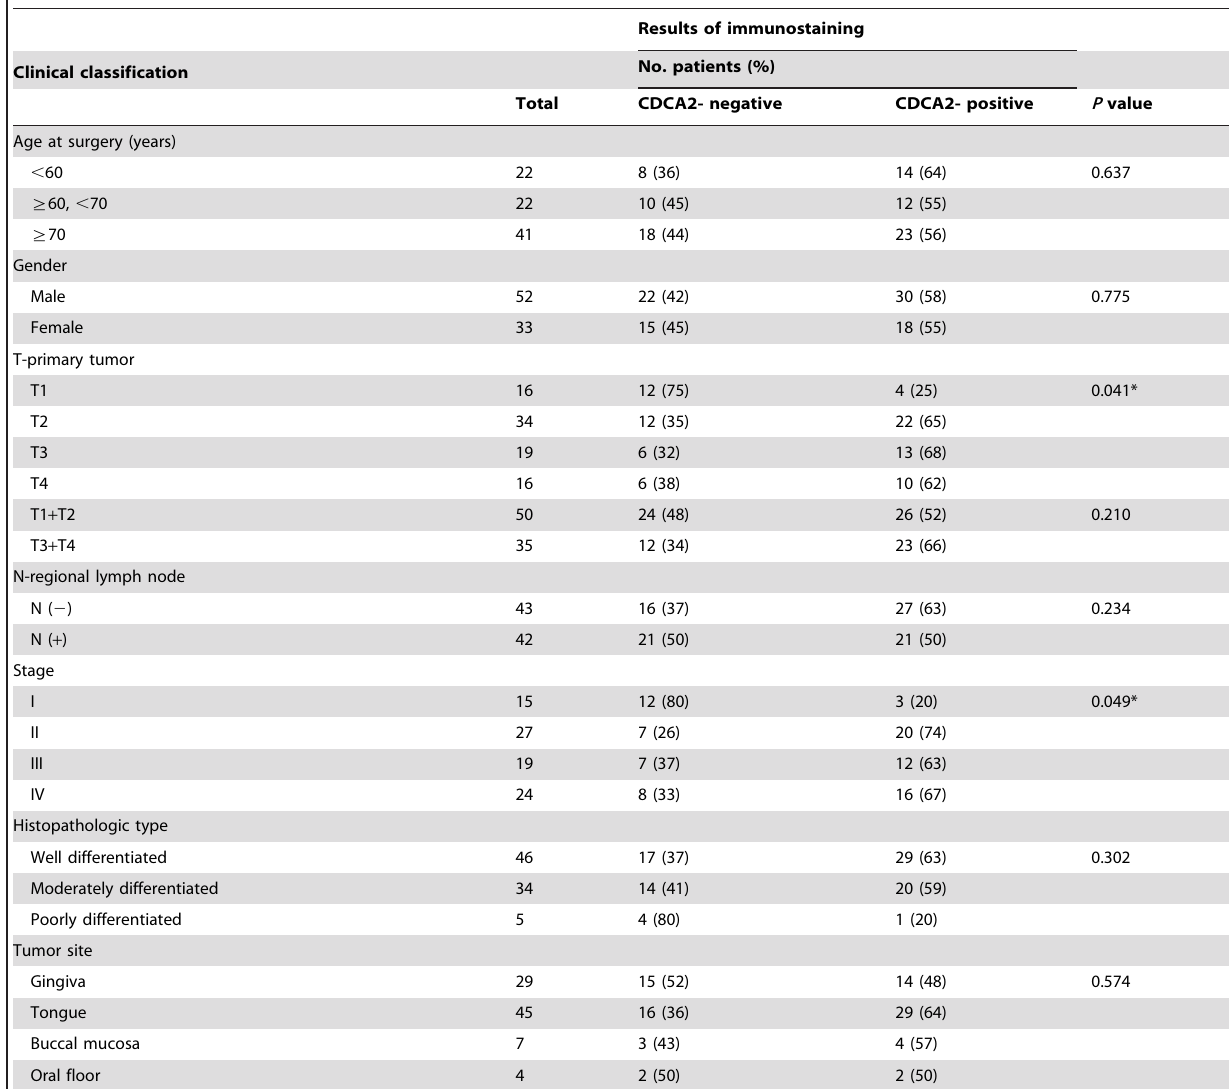
Table 1. Correlation between CDCA2 expression and clinical classification in